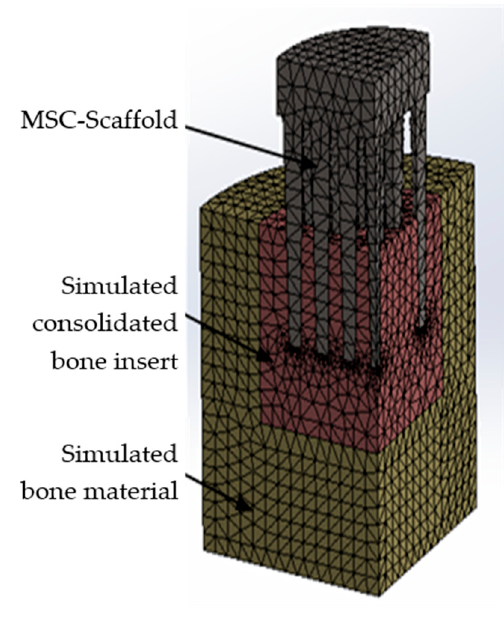
Figure 7. The modified FE model of the MSC-Scaffold prototype embedded in the periarticular bone with the simulated insert of densified bone material (according to micro-CT findings).